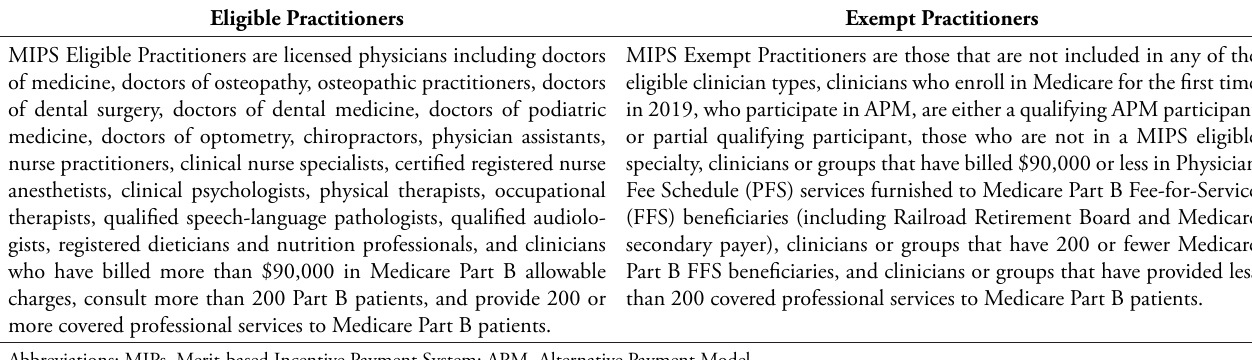
Table 1. Merit Based Incentive Payment System: Eligible and Exempt